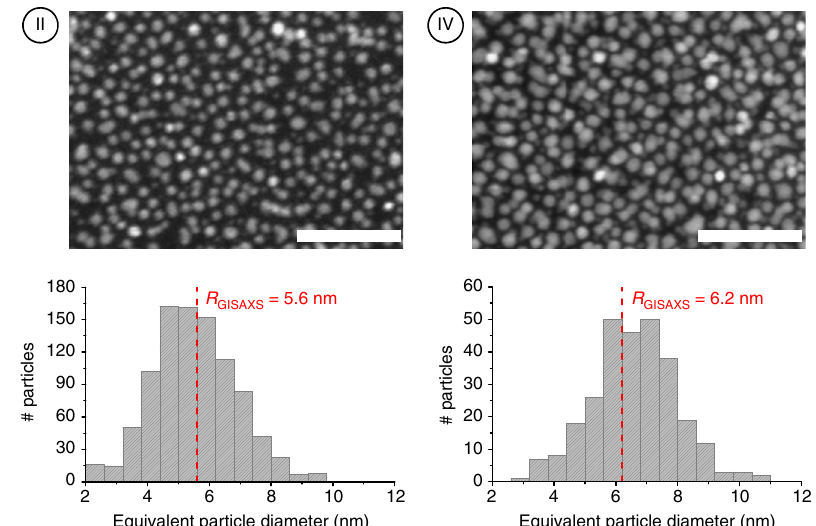
Fig. 8 HAADF-STEM characterization of the Pt nanoparticle size distribution. Tuning the particle size by combining 20 O 2 -based Pt ALD cycles with 20 (sample II) and 40 (sample IV) N 2 * -based Pt ALD cycles. HAADF-STEM images with 50 nm scale bars and derived particle size distributions